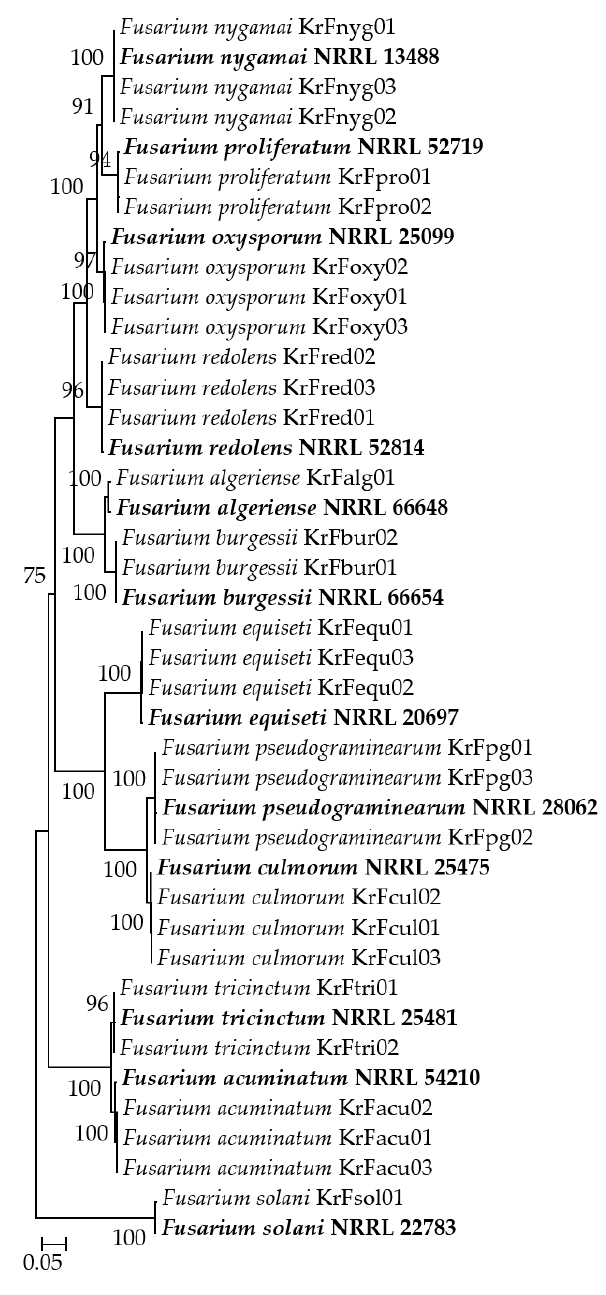
Figure 2. Phylogenetic tree based on maximum likelihood using IQ-TREE with TEF1 and RPB2 sequences of Fusarium isolates. At each node are the bootstrap values ( left ) and posterior probabilities ( right ). Sequences used as references in the present study are presented in bold.